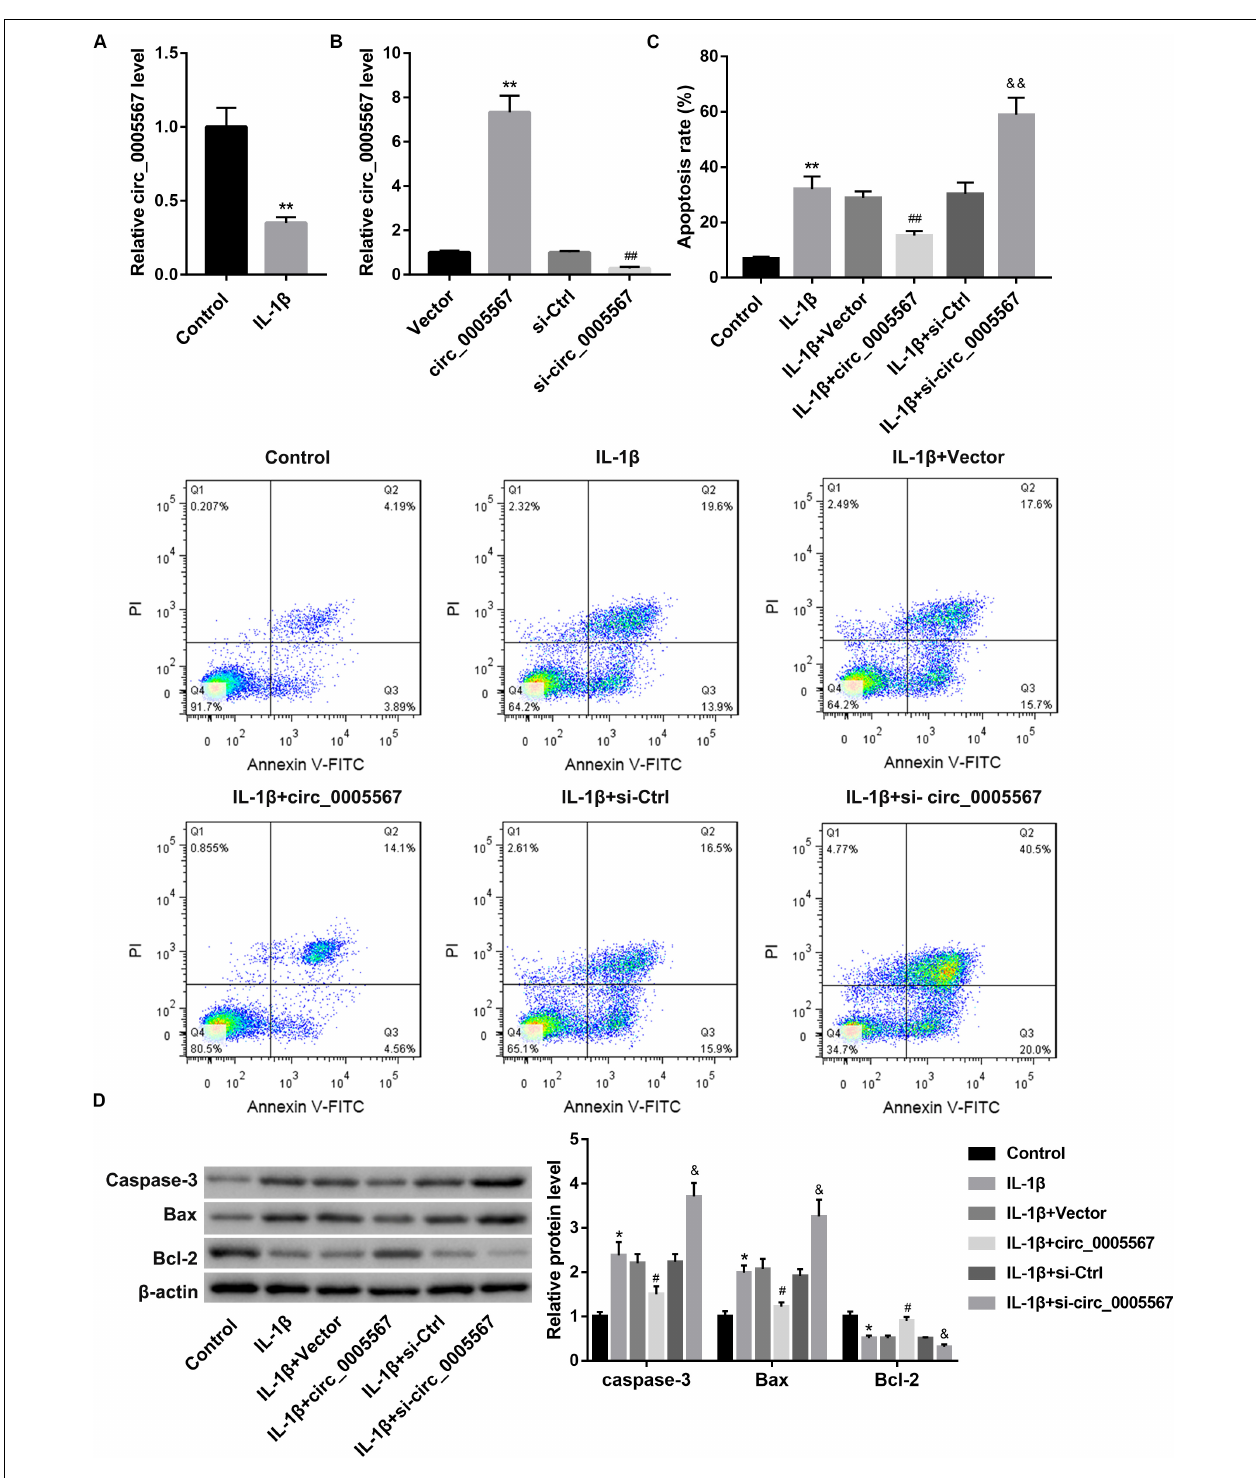
FIGURE 1 | Effect of circ_0005567 overexpression and knockdown on IL-1 β -induced chondrocyte apoptosis. (A) Circ_0005567 expression in PBS (control)- or IL-1 β -treated chondrocytes was examined by qRT-PCR. (B) Circ_0005567 expression determined by qRT-PCR analysis, (C) cell apoptosis rate determined by flow cytometry after Annexin V-FITC/PI staining, and (D) protein levels of caspase-3, Bax, and Bcl-2 examined by western blot in chondrocytes transfected with circ_0005567 overexpression vector (circ_0005567 group), empty vector, si- circ_0005567, or si-Ctrl in the presence of PBS (control) or IL-1 β . The data are expressed as mean ± standard deviation from three independent experiments. * P < 0.05, ** P < 0.01, versus the Control or Vector group; # P < 0.05, ## P < 0.01, versus the si-Ctrl or IL-1 β + Vector group; & P < 0.05, && P < 0.01, versus the IL-1 β + si-Ctrl group.